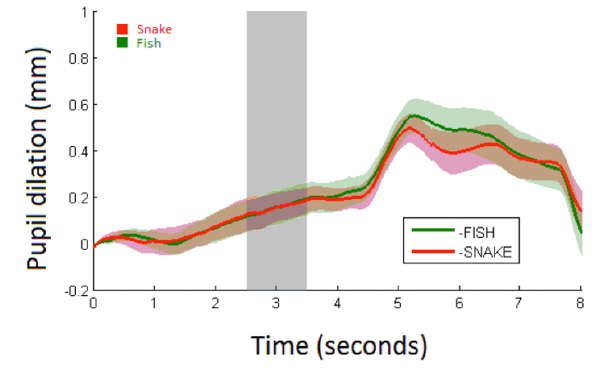
FIGURE 4 | Average Pupil dilation (mm) for snakes (red) and fish (green) over 8 s with shaded areas showing the standard errors. Stimulus onset is at 0 s with a duration of 5 s at which a white screen onsets. The analysis time period is marked in light gray.